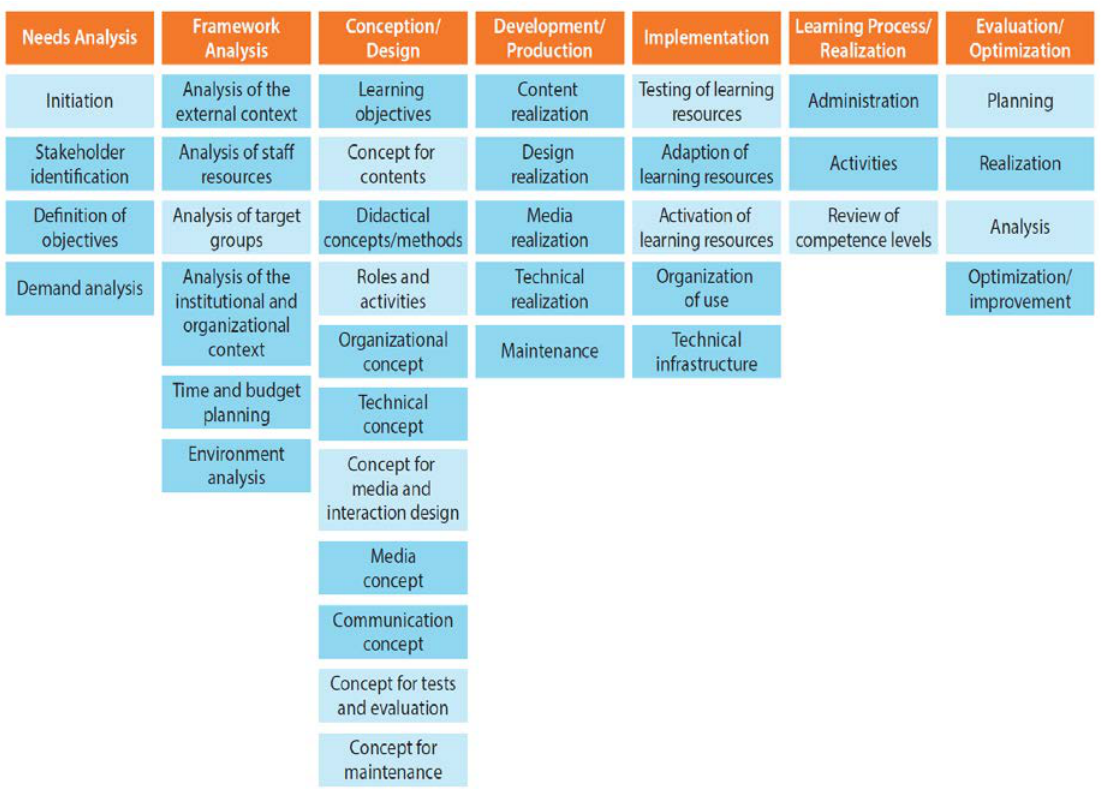
Figure 3 . Example for adaptation of ISO/IEC 40180 (former ISO/IEC